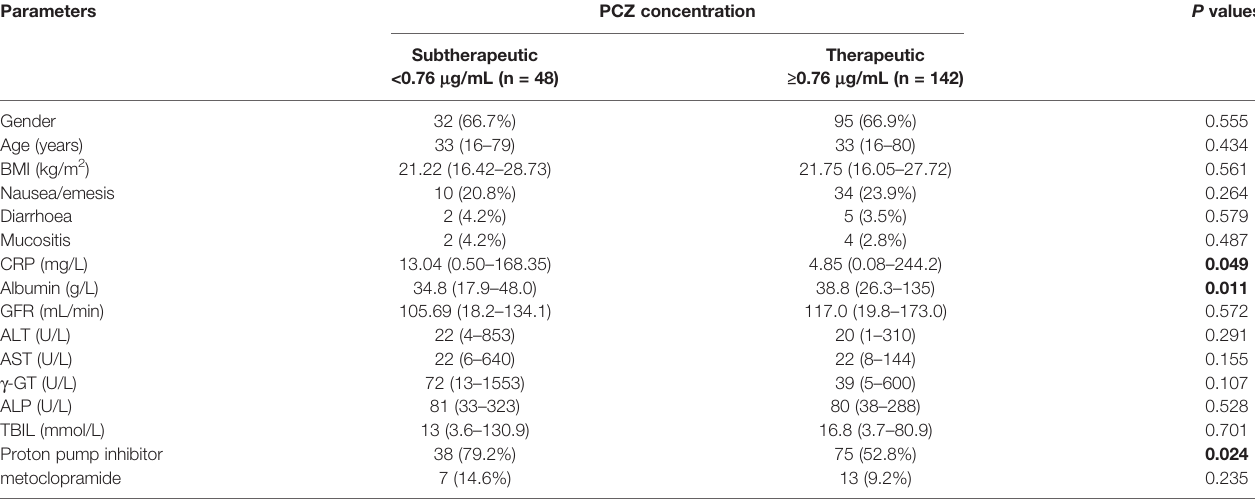
TABLE 5 | The factors in fl uencing low trough PCZ concentration.